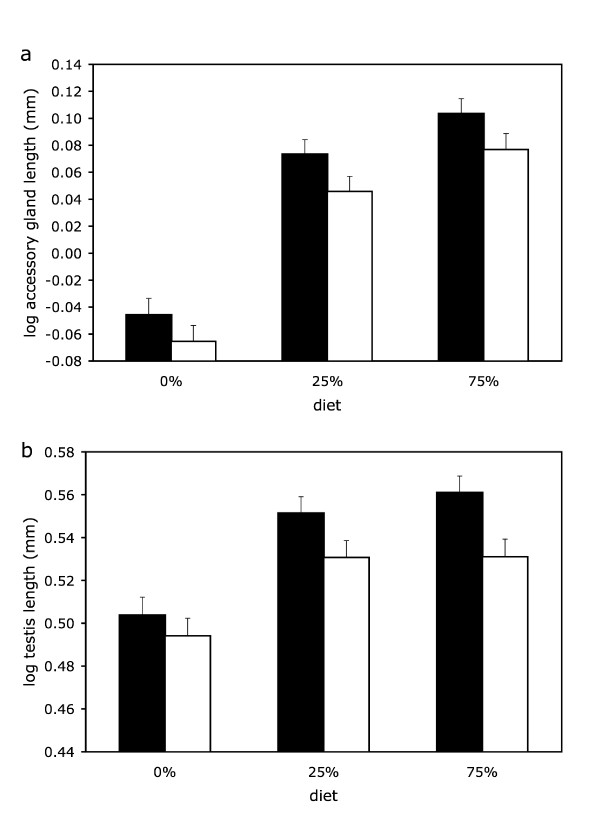
The effect of residual male eyespan and adult nutritional stress on growth of (a) the accessory glands and (b) the testes. Data represent least squares means ± s.e. log reproductive organ length (at average values of thorax length and age) for large residual eyespan (filled bars) and small residual eyespan (open bars) males across the three diets.